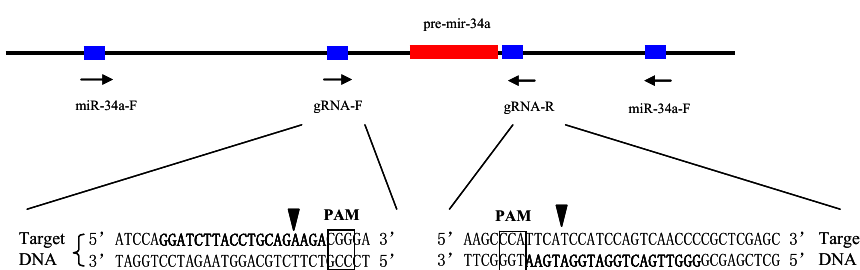
Figure 2. Schematic representation of the CRISPR/Cas9 strategy for miR-34a deletion and mutation detection. The pre-miR-34a sequence was shown in bold, and the seed sequence is underlined. Left arrows indicate that the sequences were consistent with the given sequences; right arrows indicate that the sequences were reverse-complement of the given sequences. The box indicates the PAM sequence.